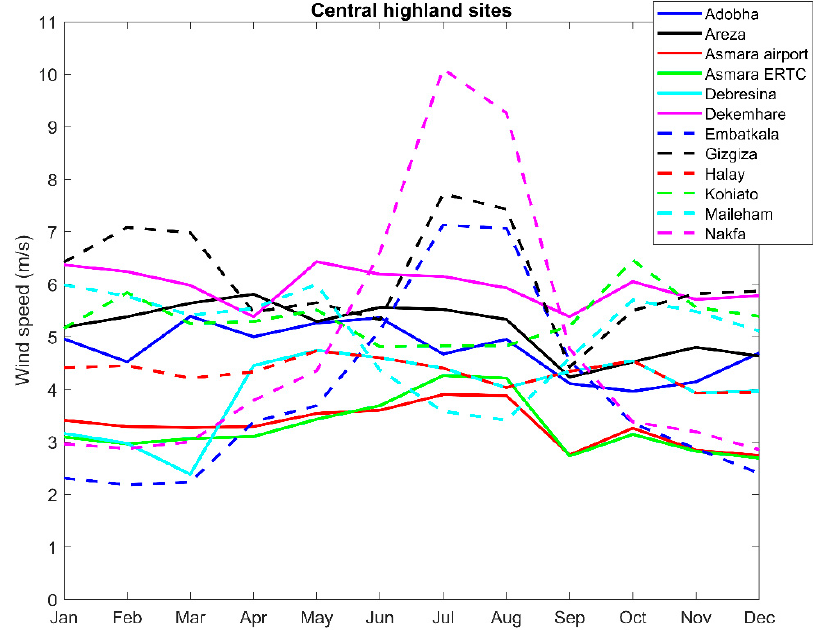
Figure 3. Mean wind speed per month for the year 2000 for the central highland sites.